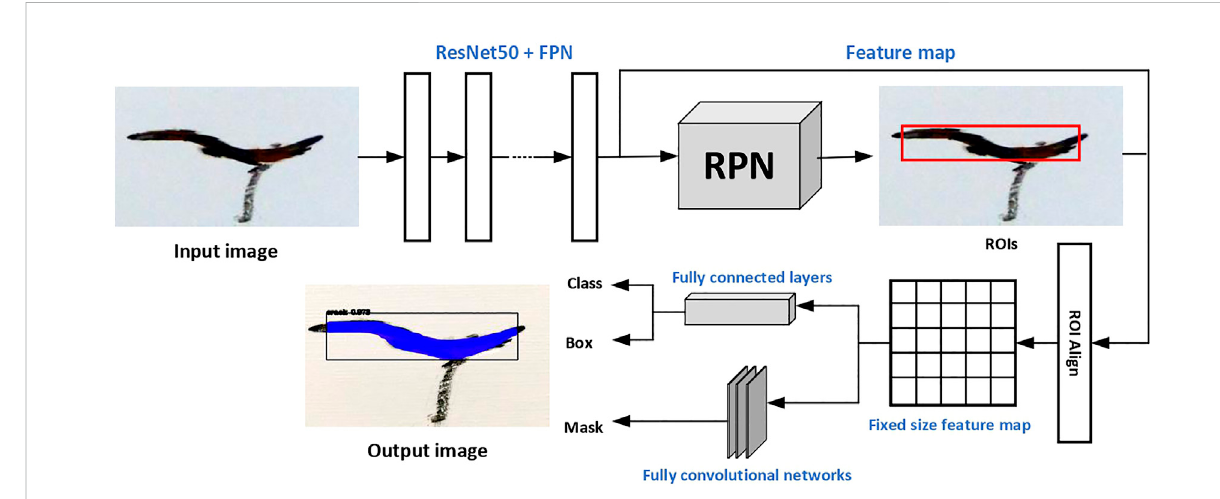
FIGURE 4 Architecture of the Mask RCNN.